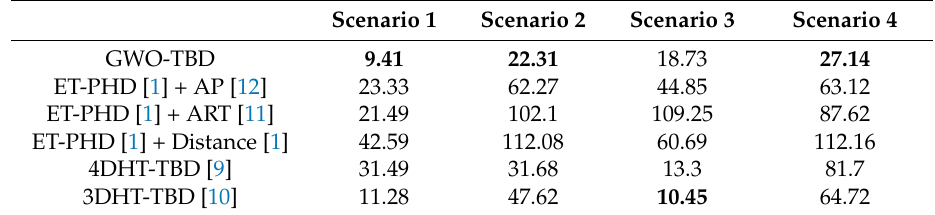
Table A5. OSPA distance of real